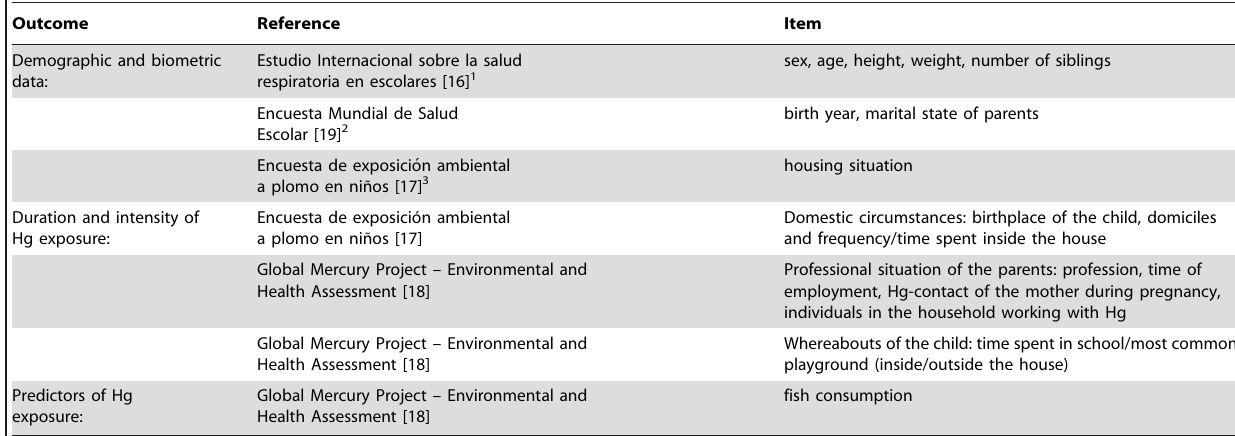
Table 1. Questionnaire Items.